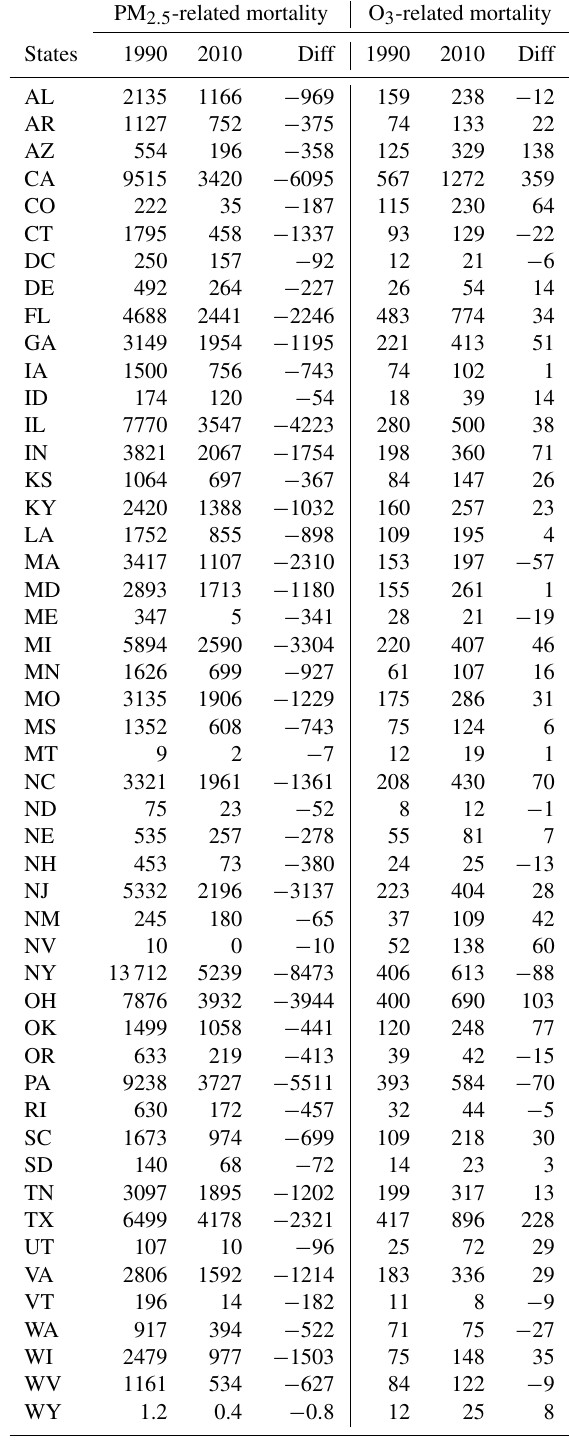
Table 2. The mortality burden for 48 US states and the District of Columbia in 1990 and 2010, and the absolute changes from 1990 to 2010. Units are deathsyear − 1